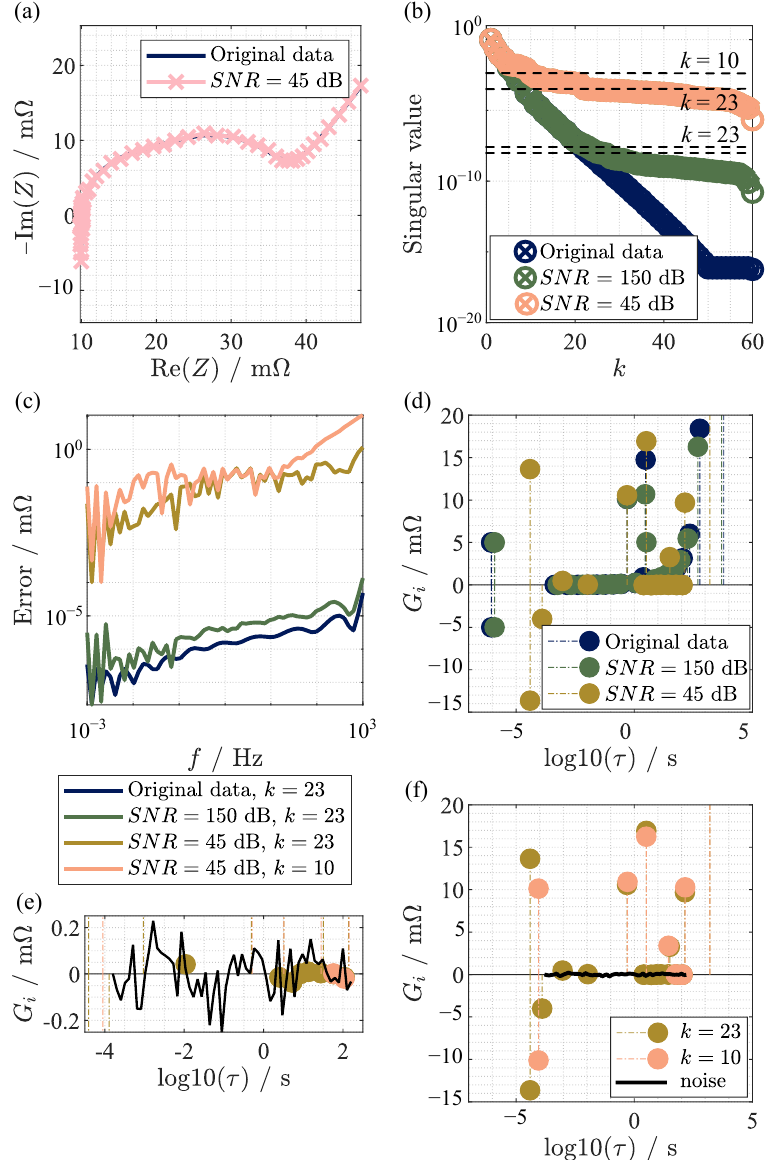
Figure 5. Nyquist plot ( a ), SVD ( b ), error of magnitude ( c ), distribution of gains ( d ) for different level of noise. Distribution of gains for SNR = 45dB for different model orders ( e ), zoom for the different model orders ( f